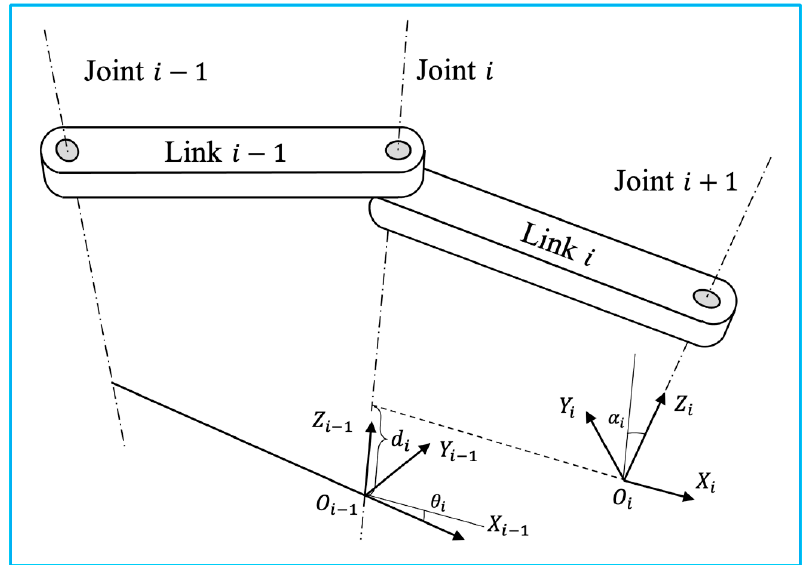
Figure 4. Two adjacent links with a revolute joint with the relative position denoted using Denavit- Hartenberg convention (adapted from [23]).